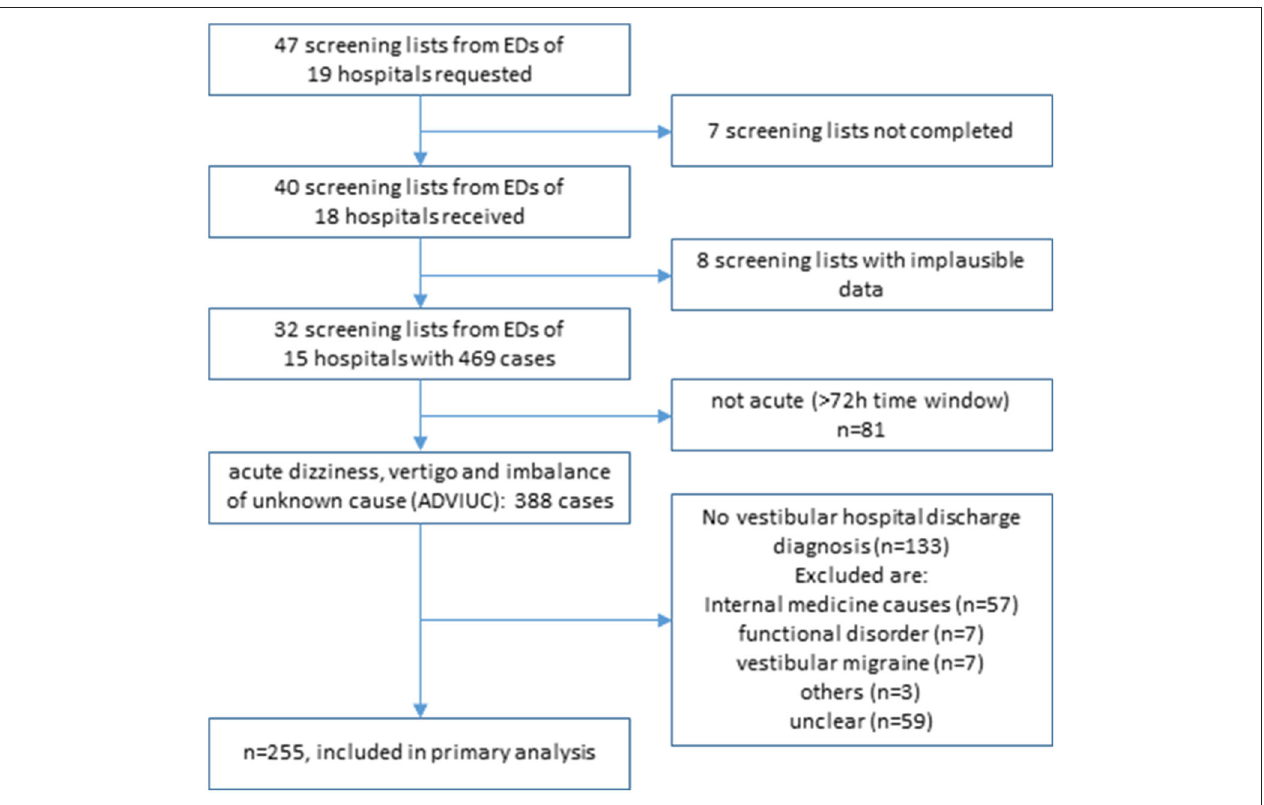
FIGURE 4 | Flowchart of the study cohort.